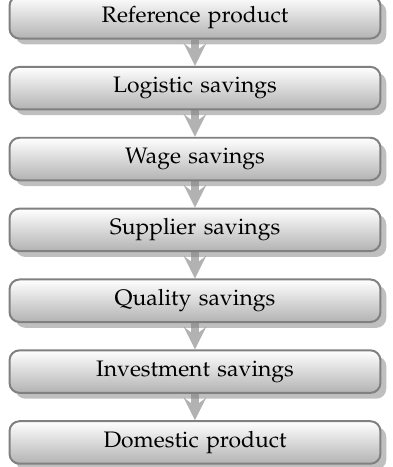
Figure 1. Savings through local